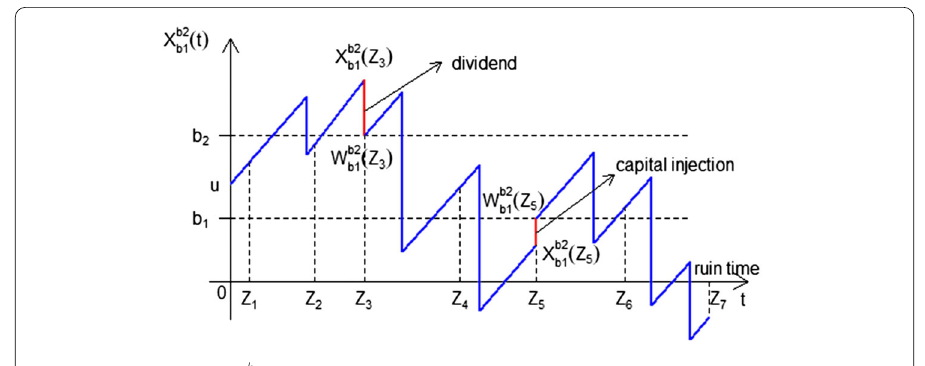
Figure 1 Sample path of X b 2